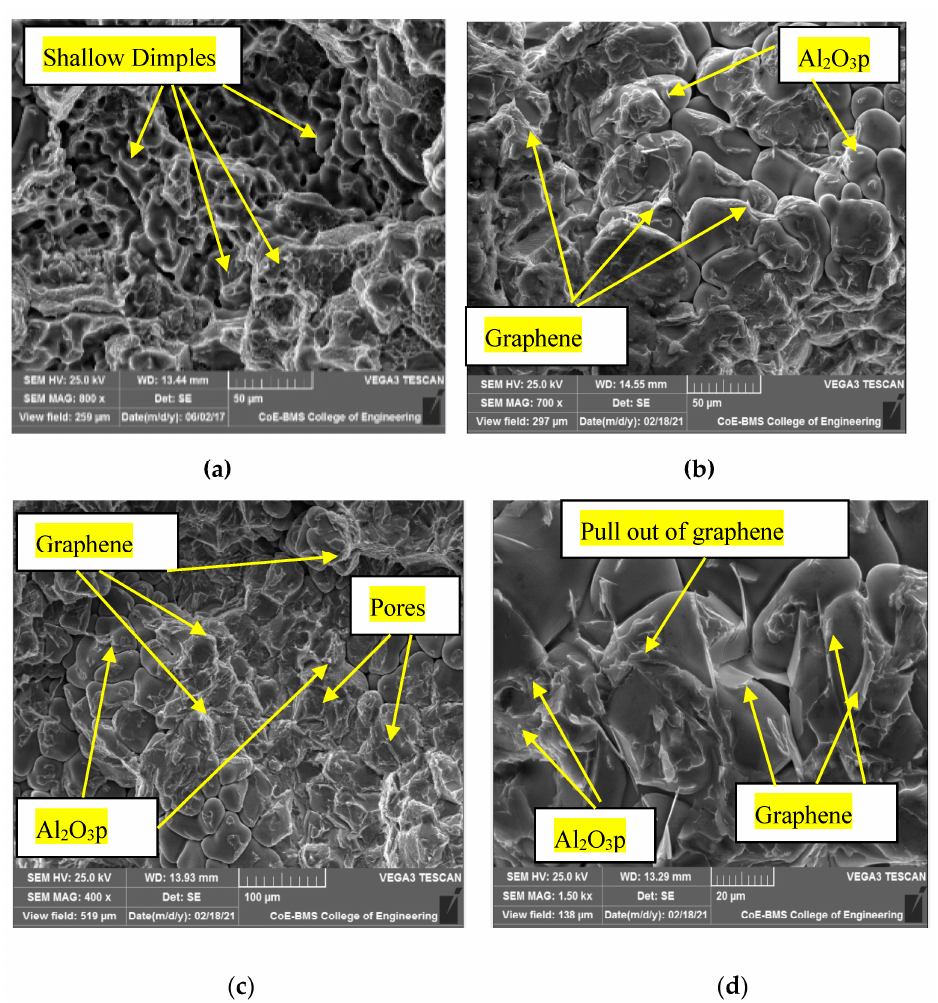
Figure 7. SEM images of ( a ) Al6061; ( b ) Al6061 + 1 wt. % Graphene + 5 wt. % Al 2 O 3 composites; ( c ) Al6061 + 1 wt. % Graphene + 10 wt. % Al 2 O 3 composites; ( d ) Al6061 + 1 wt. % Graphene + 15 wt. % Al 2 O 3 composites.